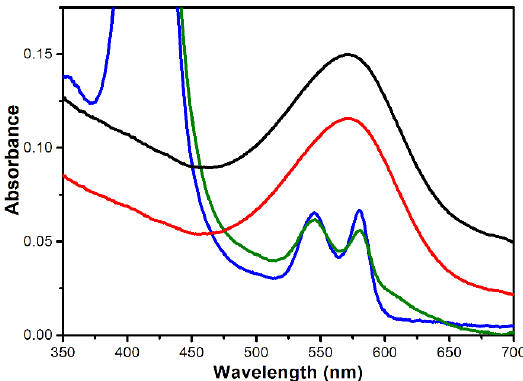
Figure 2. Overlapping absorption spectra of ( red ) 50 μ g/mL b-PM, ( black ) 50 μ g/mL PM, ( blue ) 100 μ g/mL HbA0 and ( green ) 100 μ g/mL HbA1c. The monomeric extinction coefficients of b-PM, PM, HbA0 and HbA1c at 532 nm are calculated to be 49,451, 68,061, 7368 and 9066 cm − 1 · M − 1 , respectively.